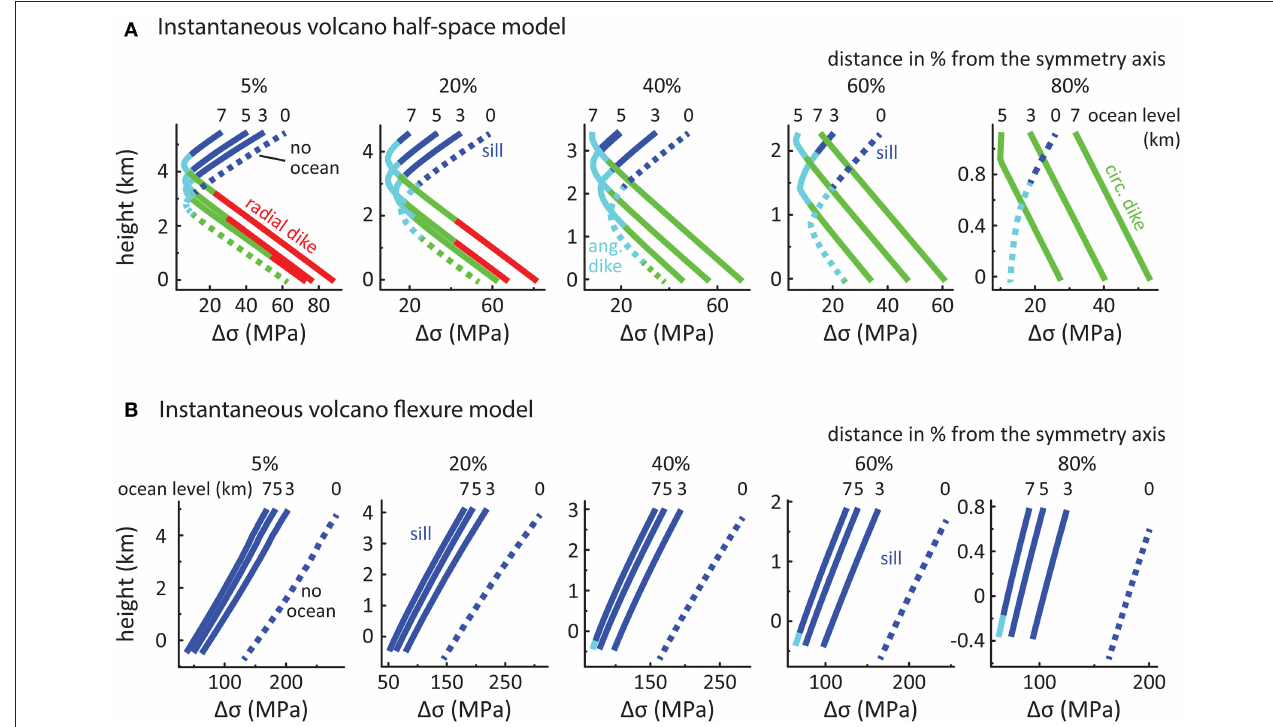
FIGURE 3 | Differential stress magnitudes, and magmatic intrusion types predicted from principal stress orientations along the internal cross-sections for instantaneously-formed volcanoes in (A) half-space and (B) flexure models. Dashed lines represent the model without an ocean load. Solid lines represent models taking into account different ocean loads (with the sea levels in km given above each line). Dark blue color represents sill intrusion ([0 ◦ -20 ◦ ] between σ 3 and the z-axis), light blue color represents angular dike intrusion [(20 ◦ -70 ◦ ) between σ 3 and the z-axis], green color represents circumferential dike intrusion ([70 ◦ -90 ◦ ] between σ 3 and the z-axis), and red color represents radial dike